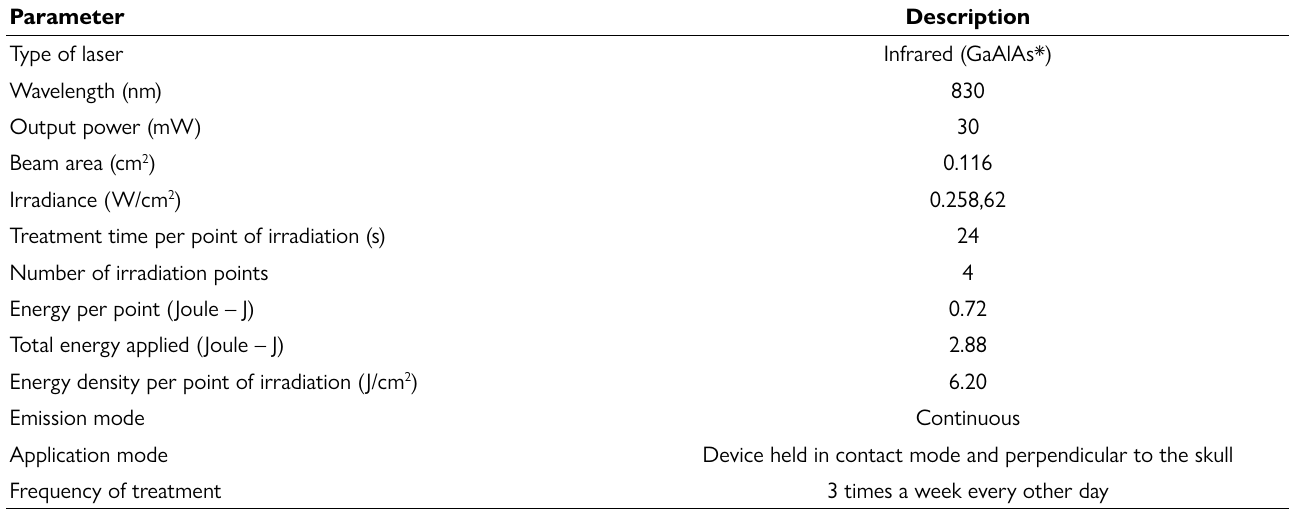
Table 1. Details of the parameters used for PBM